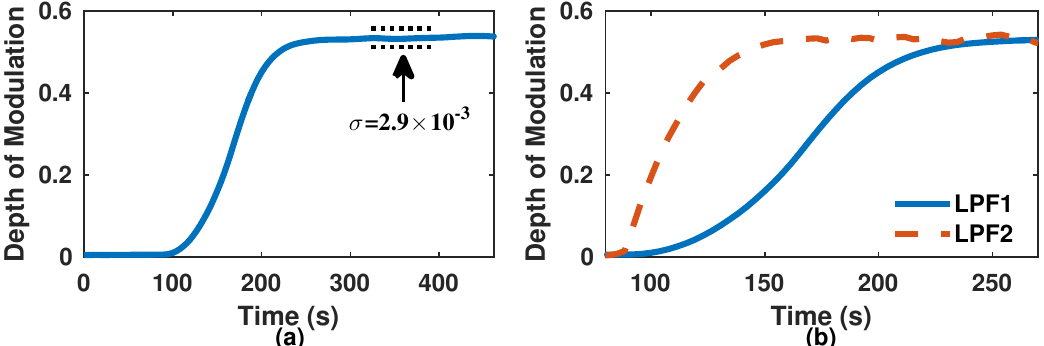
Figure 8. ( a ) Depth of modulation as function of time and its standard deviation. ( b ) Depth modulation considering a high order low pass filter (LPF1) and a first order low pass filter